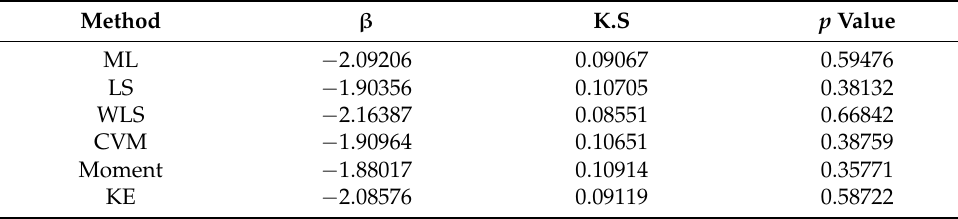
Table 5. p -values for comparing methods with the relief/survival